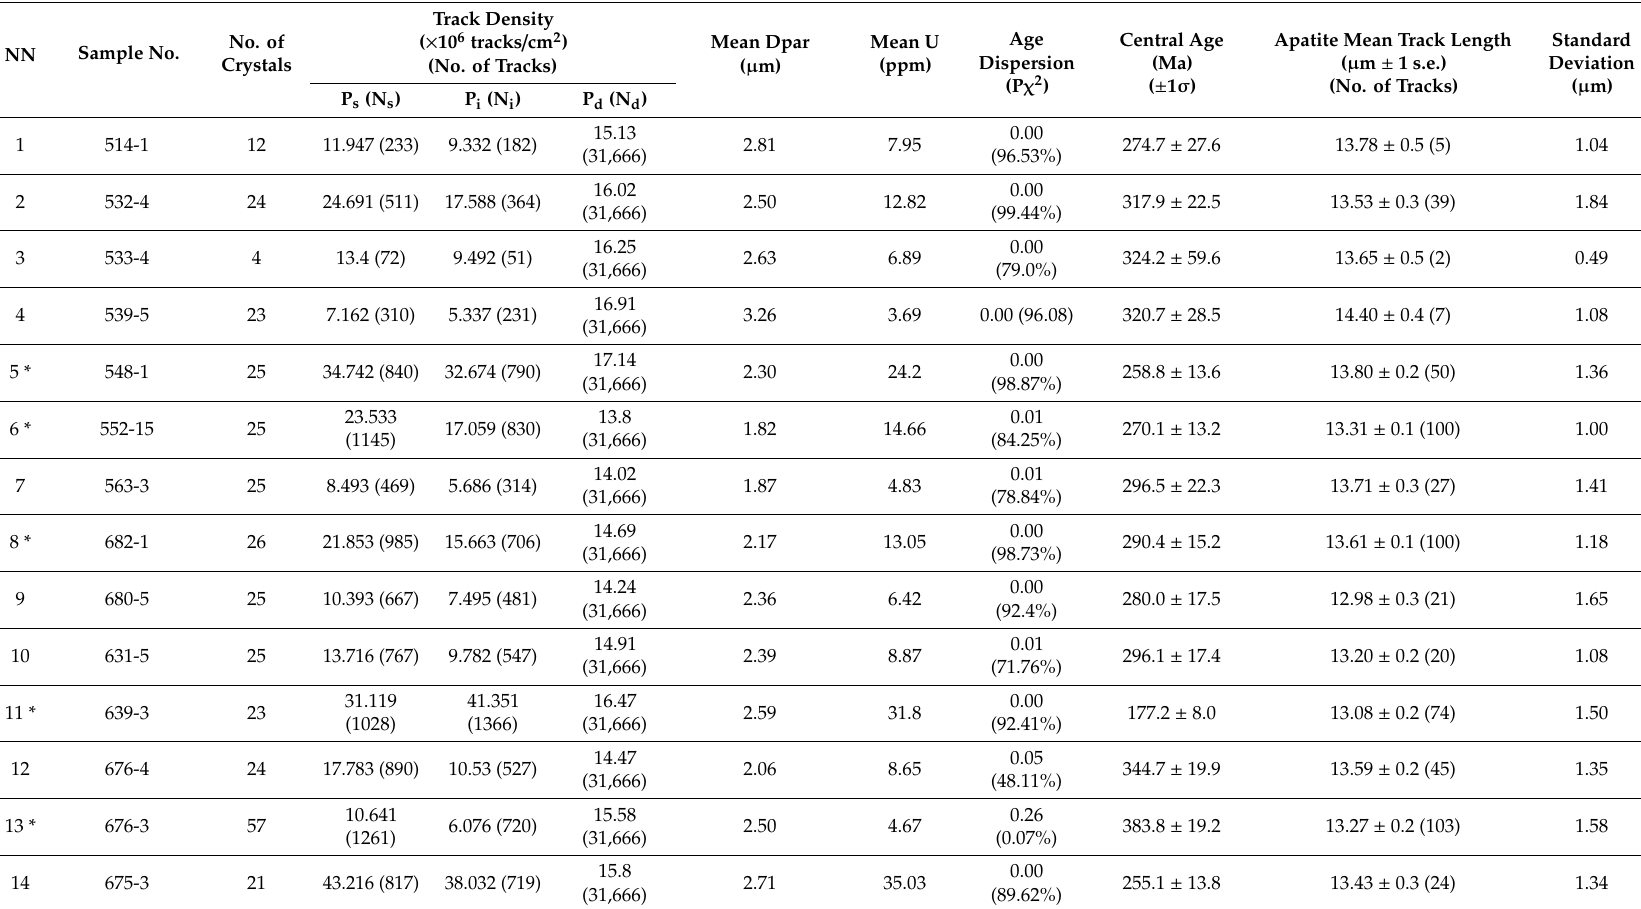
Table 2. Apatite fission-track